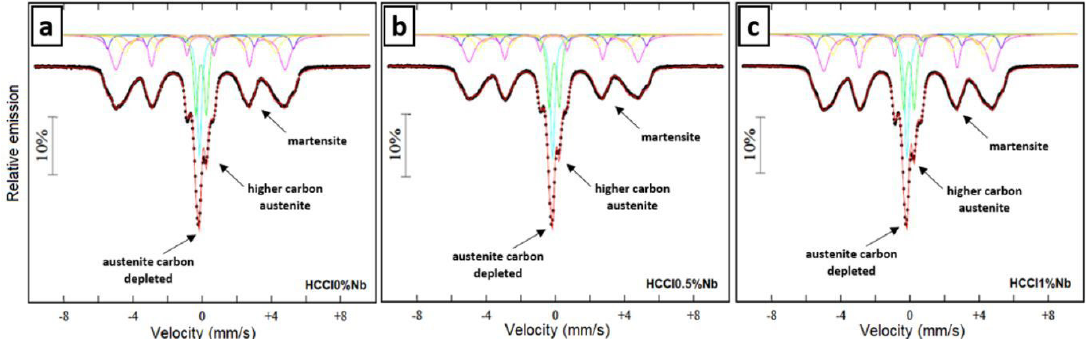
Figure 8. Mössbauer spectra obtained from analyzed samples. (a) HCCI0%Nb; (b) HCCI0.5%Nb; (c) HCCI1%Nb.